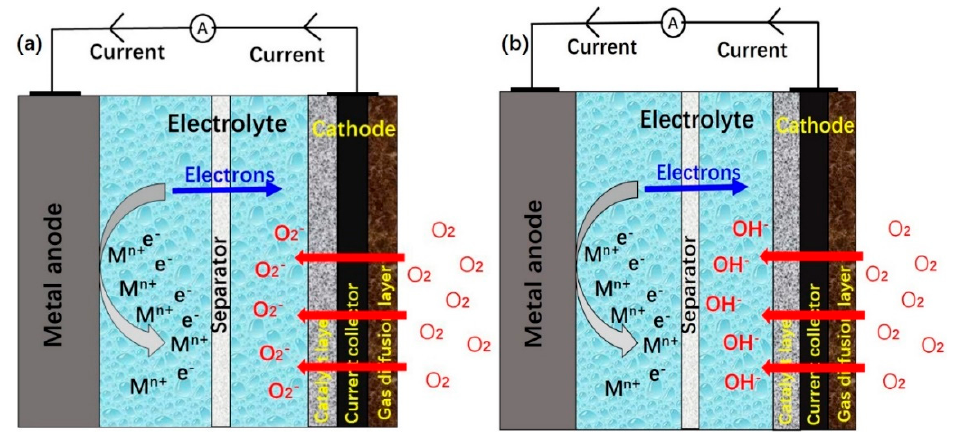
Figure 3. Schematic diagrams of MABs working principles for ( a ) non-aqueous electrolyte, and ( b ) aqueous electrolyte.